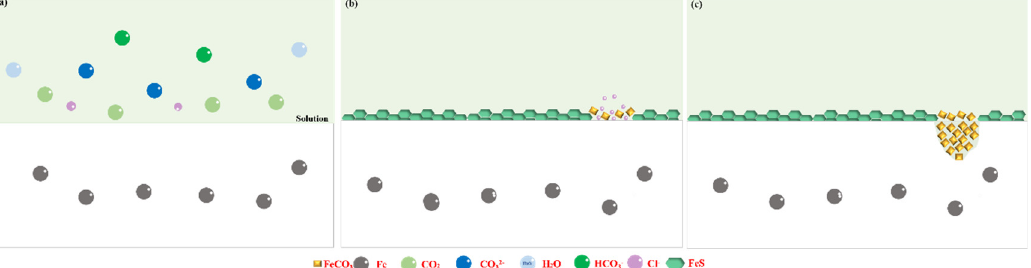
Figure 21. Schematic diagram of the mechanism of pitting corrosion of T95 steel in the liquid phase ( a : Interaction of ions with metal substrates; b : Deposition of FeS and FeCO 3 ; c : Cl − pass (( a ): Interaction of ions with metal substrates; ( b ): Deposition of FeS and FeCO 3 ; ( c ): Cl − pass through through the corrosion product film to form pitting corrosion). the corrosion product film to form pitting corrosion).